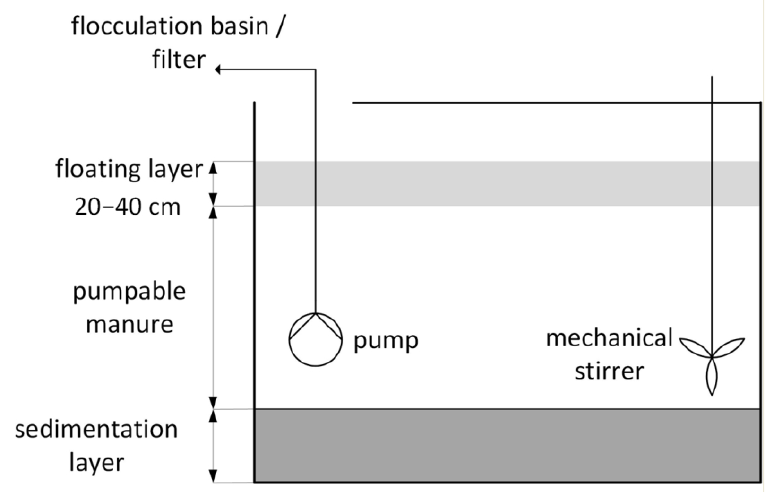
Figure 1. Illustration of the sample extraction from the mixed and breeding manure tanks. The collected manure was processed either by simple filtration using bag filters (two subsequent stages: 200 µm and 100 µm) or flocculation using a 40 mass-% solution of FeCl 3 (industrial grade) for pH-adjustment (pH < 6) together with commercially available flocculants (type 202 L, 0.5 – 1%